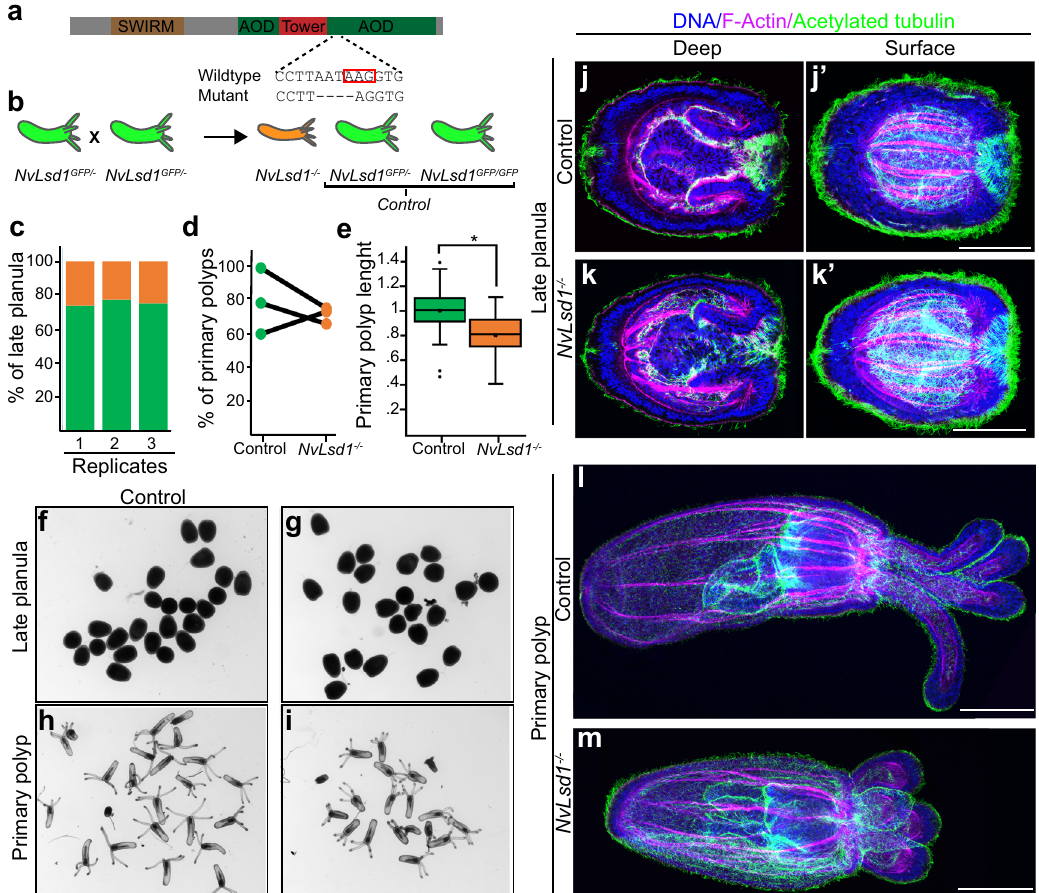
Fig. 3 Generation and characterization of NvLsd1 mutants. a Schematic showing the structure of the NvLsd1 protein and the position and sequence of the mutation. The red box indicates the position of K644. b Cartoon depicting the crossing scheme used in all experiments with the NvLsd1 mutants. c Quanti fi cation of the percentage of late planula which was control (in green) or NvLsd1 − / − (orange) across three independent biological replicates. d Percentage of control and NvLsd1 − / − late planula which developed into primary polyps. Three independent replicates are shown and matched samples are connected by a black line. e Box and whisker plot showing the measurement of body column length in control and NvLsd1 − / − primary polyps. The total body length is normalized to control. n = 50 (control), 51( NvLsd1 − / − ) animals examined over three independent experiments. Data shown are combined from all three replicates. Boxes indicate fi rst and third quartile, median is represented by a line, mean is indicated by an asterix, whiskers indicate the minimum and maximum, and outliers are shown as dots. Statistical signi fi cance was determined using a two-tailed Student ’ s t test * p = 0.00000038344. Source data are provided as a Source Data fi le ( f – i ) Bright fi eld pictures of control or NvLsd1 − / − animals at late planula and primary polyp stage. Genotype is shown on top and stage is shown to the left. ( j – m ) Confocal images of immuno fl uorescence staining on control and NvLsd1 − / − late planula ( j , k ) and primary polyp ( l , m ). DNA is shown in blue, acetylated tubulin in green and F-actin in magenta. ( j ) and ( k ) show several projected confocal slices from the inside of the planula and j ’ and k ’ show several projected slices from closer to the surface. Images shown are representative samples from at least two independent replicates with >10 animals per replicate. Scale bar: 50 μ